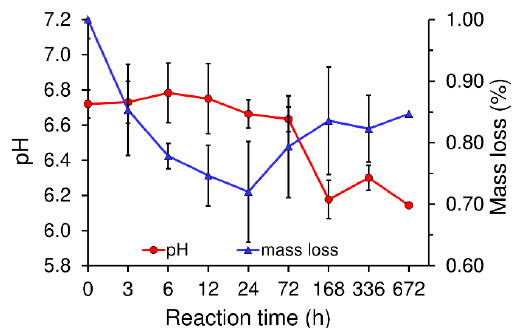
Figure 4. Change in the pH and mass loss of the 20 w/v % copolymer/ α -TCP cement with an L/P of 0.5 0.5 g · g − 1 at 37 ◦ C and immersed in ultrapure g . g − 1 at 37 °C and immersed in ultrapure water.